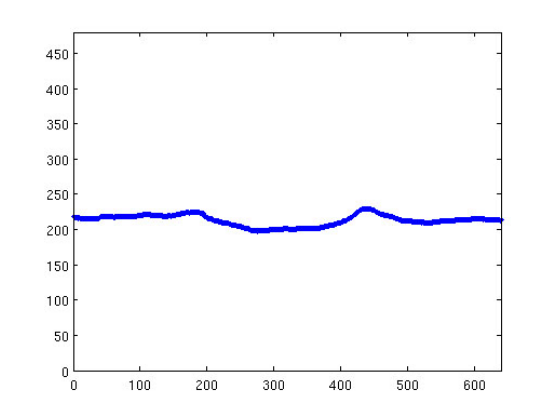
Figure 5. Computed sky–terrain interface using the synthetic image.